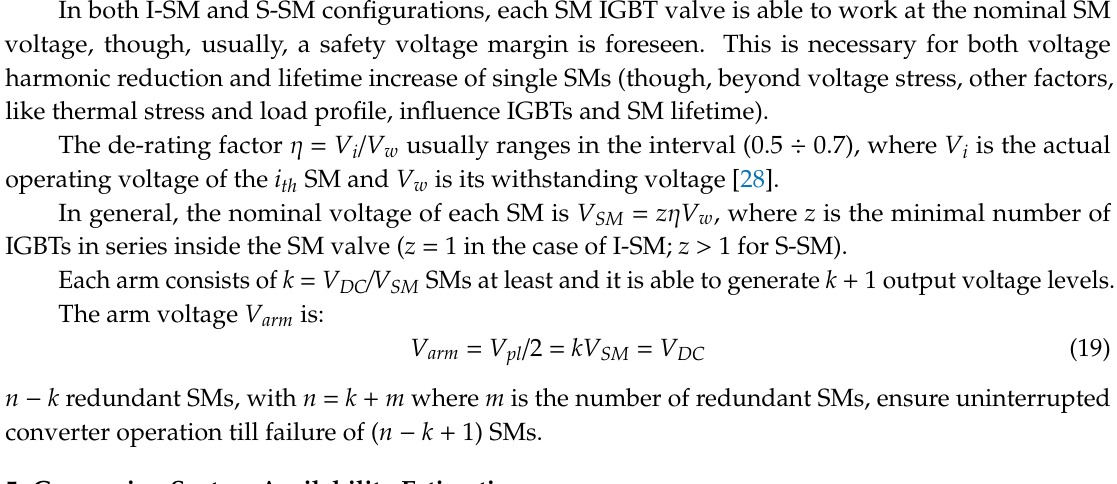
Figure 9. I-SM and S-SM MMC configurations.